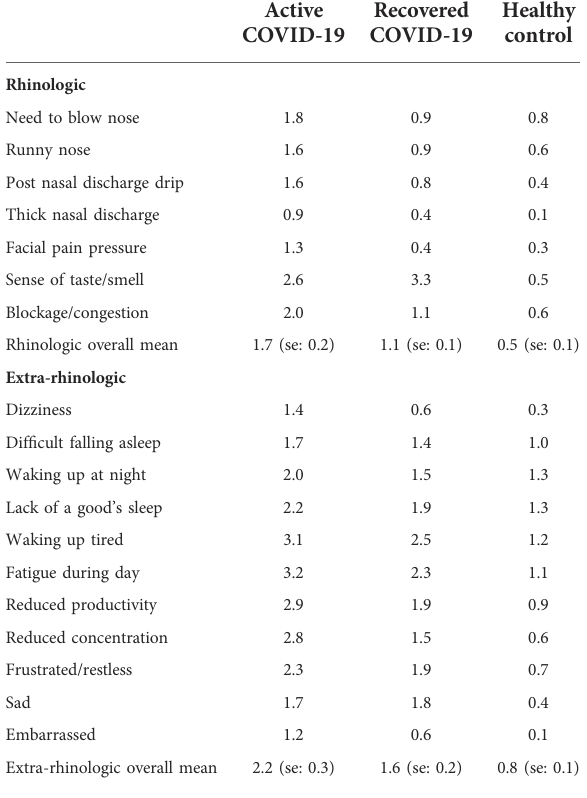
TABLE 3 Average SNOT-22 (mean) scores by item and COVID group.